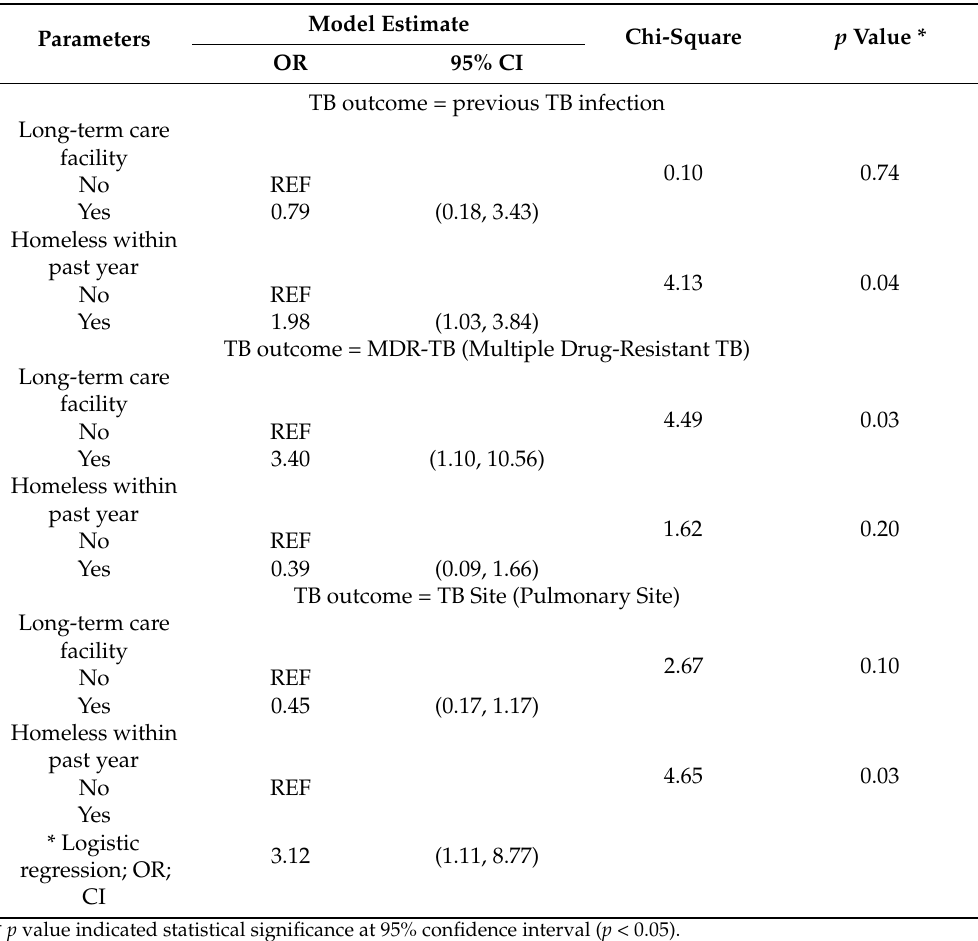
Table 4. Bivariate logistic regression of TB Outcome variables associated with living in long-term care facilities and homelessness. Model Estimate Chi-Square p Value Parameters